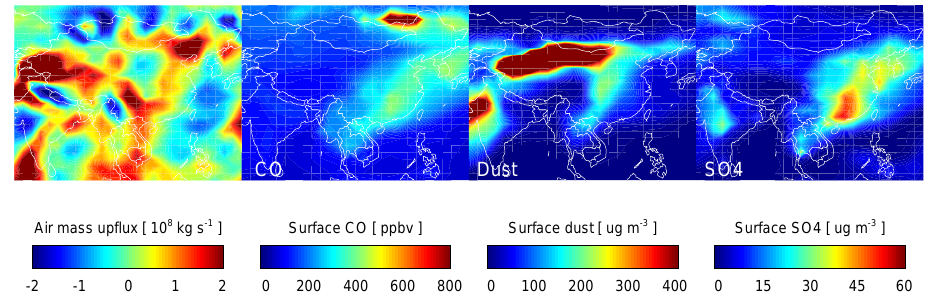
Fig. 7. Distributions of tropospheric vertical air mass flux, and simulated CO, dust and sulfate mixing ratio in the first model layer during 1–2 May